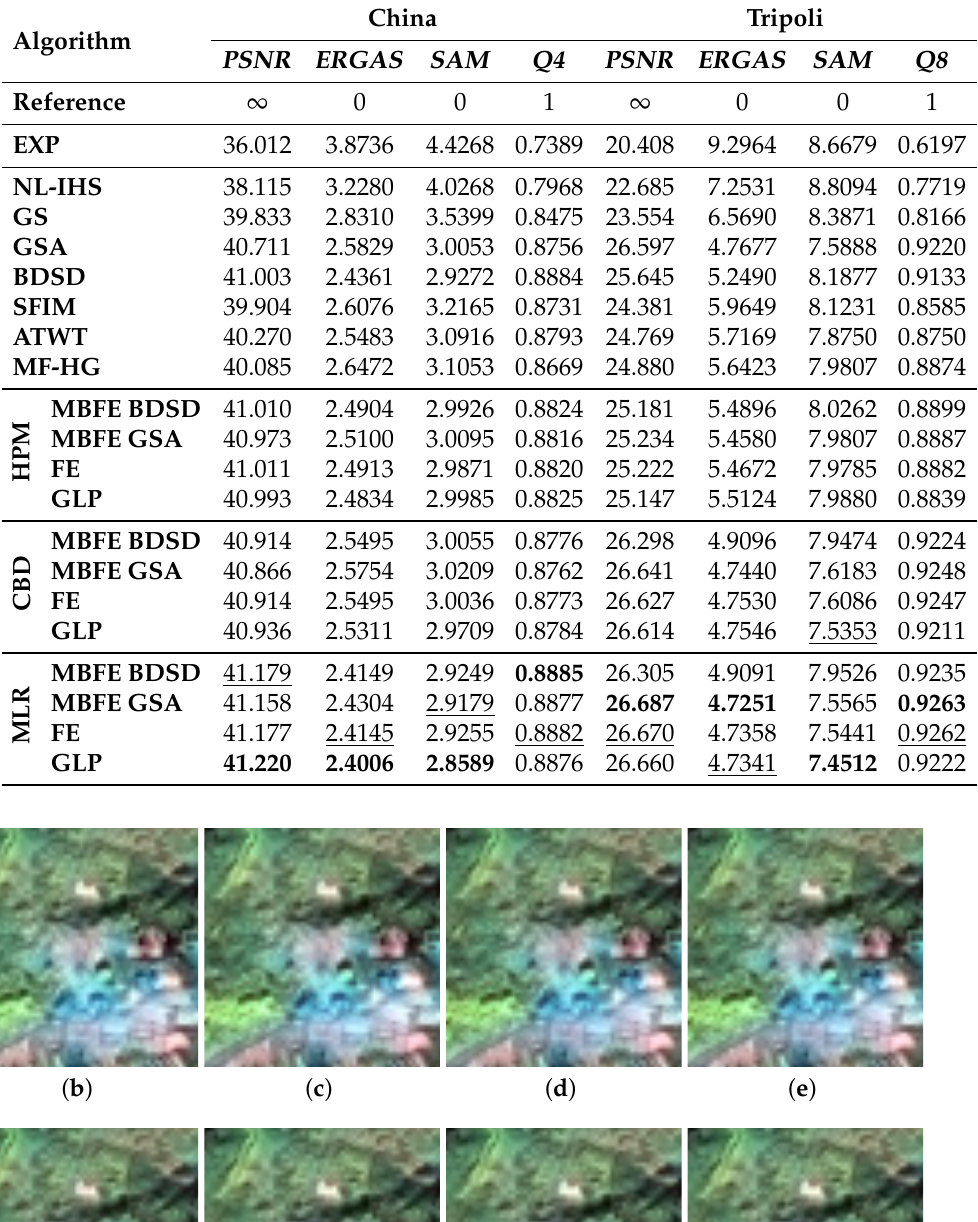
Table 1. Reduced resolution assessment: the first row contains the reference value for each index. The best results among the different versions of the MTF-GLP approaches are in boldface; the second best are underlined.